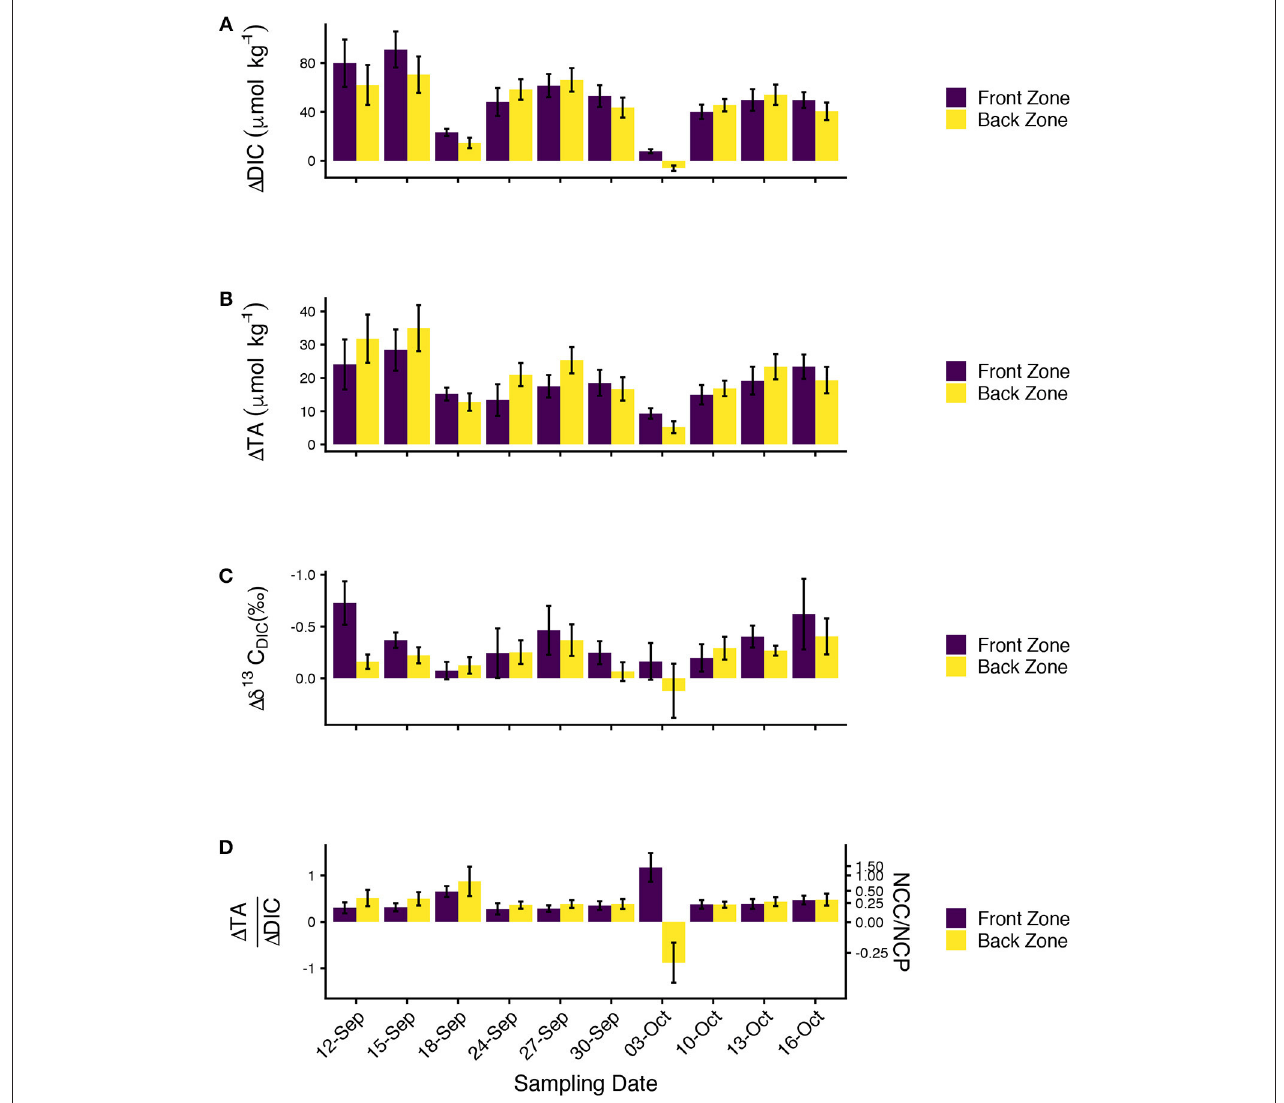
FIGURE 7 | (A) 1 DIC , (B) 1 TA , (C) 1δ 13 C DIC , and (D) 1 TA /1 DIC for the front (purple) and back (yellow) zones for all ten sampling days showing biogeochemical changes in water chemistry due to community metabolism. All data are presented as